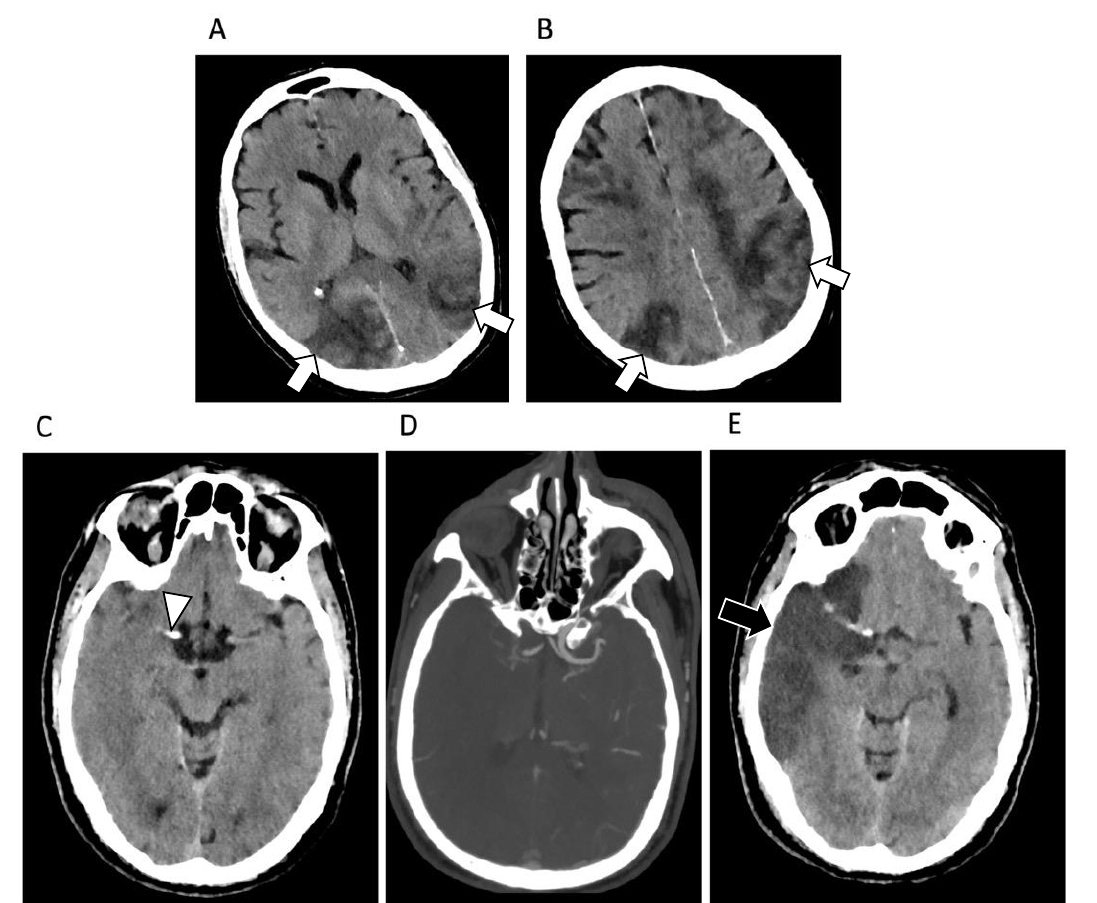
Figure 4. Brain findings in COVID-19 patients. ( A , B ) Axial brain CT images of a 56-year-old man affected by SARS-CoV-2-related pneumonia showing multiple hypoattenuating areas located in the cortical junction bilaterally, with a predominant extension in the parietal and occipital lobes, due to ischemia (white arrows). ( C ) Axial brain CT images of a 71-year-old woman affected by SARS-CoV-2-related pneumonia showing hyperdense artery sign in the right middle cerebral artery (white arrowhead), due to acute thrombosis. This finding was confirmed by brain CT angiography ( D ) show- ing a complete thrombosis of the middle cerebral artery. After 15 days brain CT images ( E ) show a large hypoattenuating area in the fronto-parietal lobe (black arrow) due to the brain ischemia.